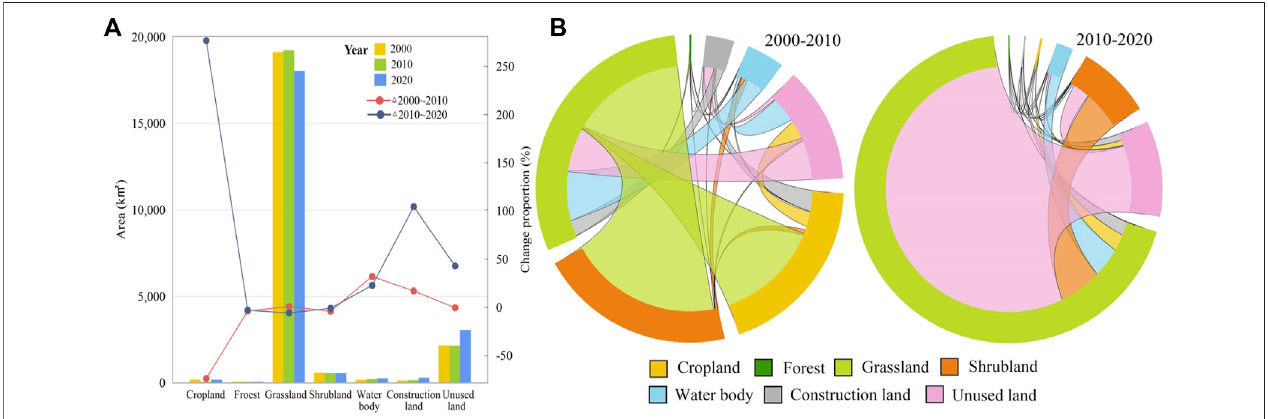
FIGURE2| Land-usechangeandland-usetransitionintheQinghai – TibetHighwaycorridor.Thechordgraphintuitivelyrepresentsthetransitionsbetweendifferent land-use types, the width of the land-use section represents the area of land use (A,B) , and the transparent colors represent the fi nally gained land use after the mutual transitions between two land-use types.